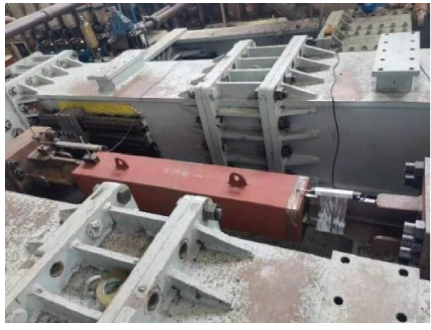
Figure 3: Buckling restrained bracings with high ductility.